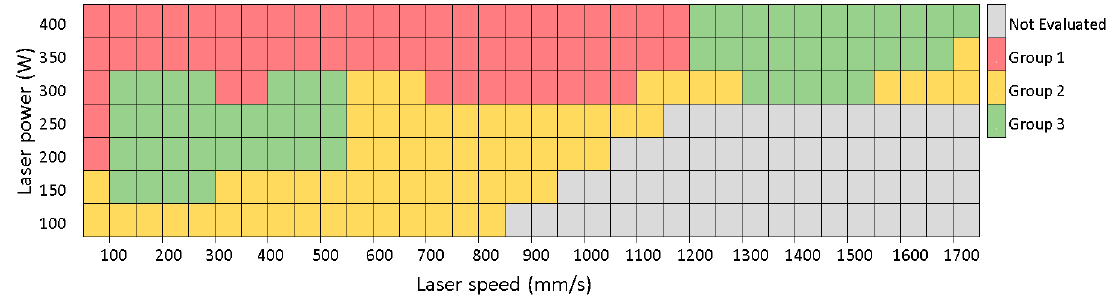
Figure 4. Process window identified from single weld track evaluation.